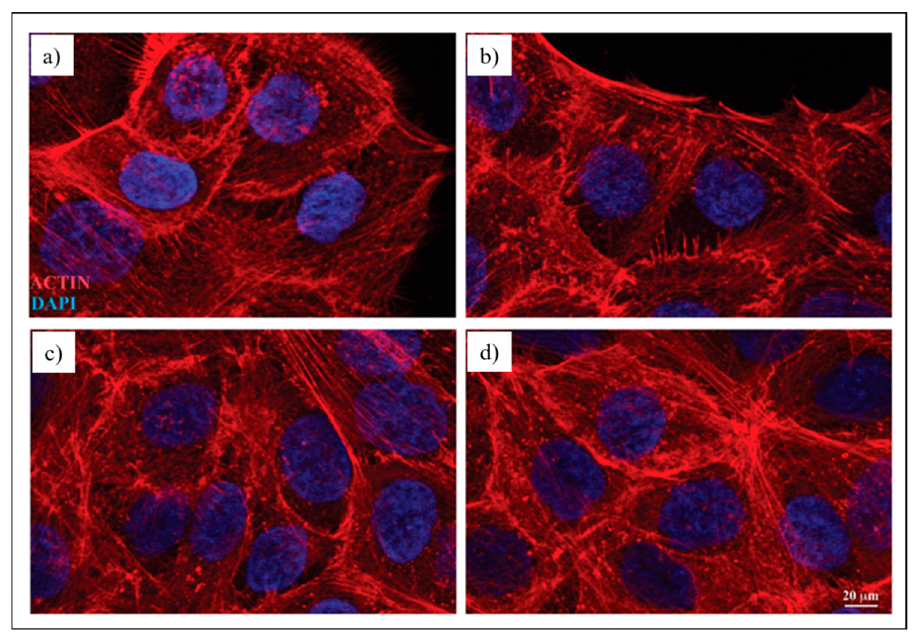
Figure 7. Immunofluorescence images of HaCaT cell morphology ( a ) without exposure or after exposure to: ( b ) EUT, ( c ) EP1GNP or ( d ) EP2GNP fabric extracts for 48 h. The actin cytoskeleton is highlighted by staining with TRITC ‐ phalloidin, and the nucleus is detected by DAPI. Bar: 20 μ m.